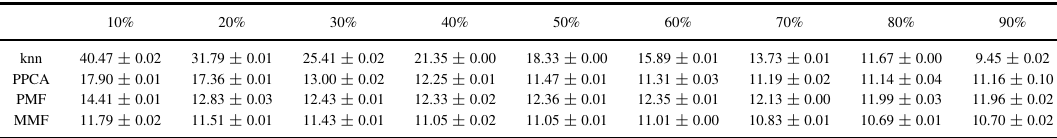
Table 2. Recovery errors on the transportation dataset (mean ±